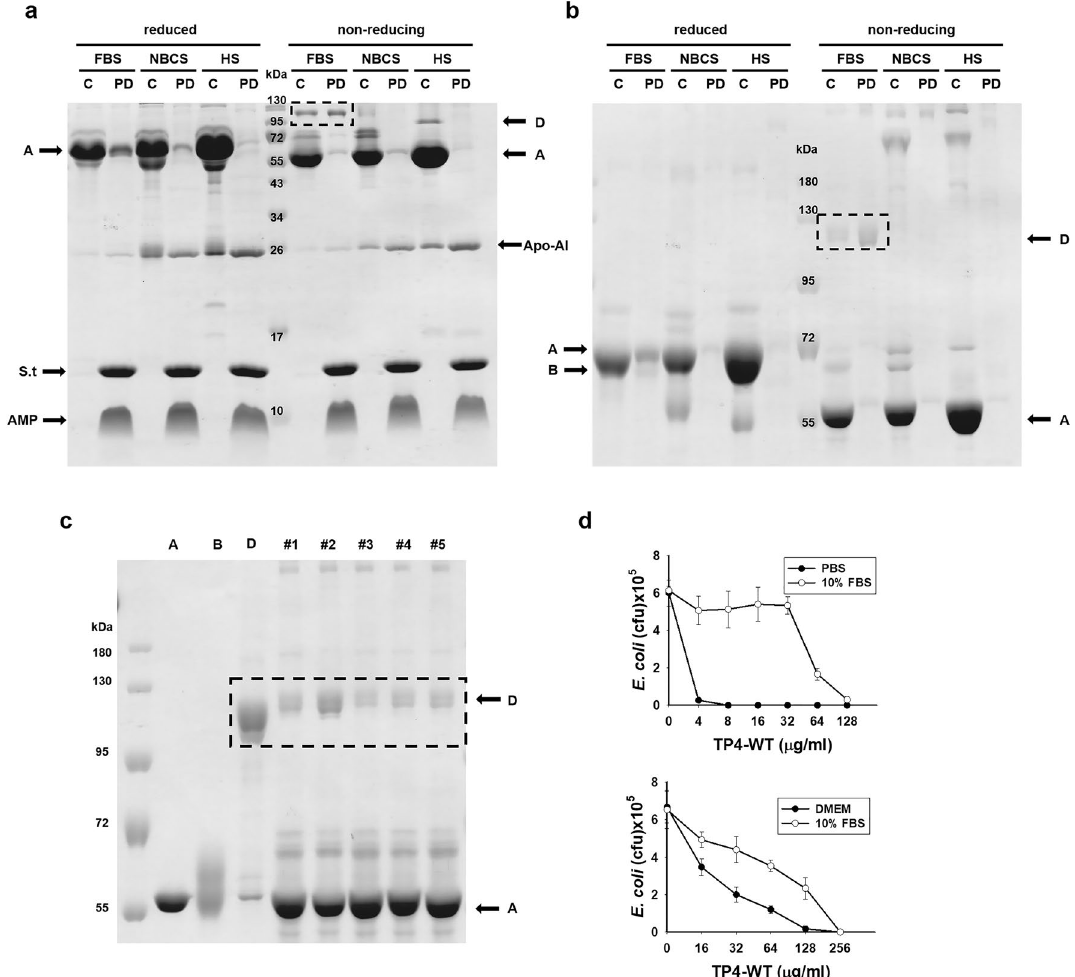
Figure 8. Analyses of albumin and α1–antitrypsin complex in the sera. ( a , b ) 0.25 μl of fetal bovine serum (FBS), newborn calf serum (NBCS) and human serum (HS) were pulled down by biotinylated TP4-A12I,A15I immobilized on Streptavidin-conjugated gel and subjected to 15% ( a ) and 8% ( b ) reduced (2.5% β-ME) and non-reducing SDS-PAGE analyses. C, control serum without pulling down; PD, pulling down ( c ) Analysis of the protein A and D contents of various FBS. 0.25 μl of crude FBS was analyzed by 8% non-reducing SDS- PAGE. # 1 to # 5 were obtained from Gibco, Co. with the lot numbers 1233075 and 1,887,129, CORNIING with the lot number 35010170, Biological Industries with the lot numbers 1823627 and 1,650,071, respectively. ( d ) Susceptibility of TP4 to serum inhibition in PBS and cell culture medium with the developmental stage of bovine, batches of serum sources (Fig. 8). Therefore, the amount of albumin/ α1-antitrypsin complex is very important because bovine serum is a major supplement of culture media which is used for the assay and production of biomolecules. In addition to the protein D (albumin/α1-antitrypsin complex), the culture medium (DMEM) which contains salts and divalent cations is also inhibitory to the anti- microbial activity of TP4 (Fig. 8). To prevent the inhibitory effects of serum component on the antimicrobial activity of AMP, the protein D in the FBS may be depleted by the AMP-immobilized beads before adding to the culture media, DMEM or RPMI. The band shift of TP4-A12I,A15I on native PAGE occurred with bovine protein D, but not with protein A (Fig. 3a). Interestingly, the binding between protein D and TP4-A12I,A15I was blocked if the protein D-con- taining mixture was pre-incubated with ibuprofen, but not with warfarin or phenytoin, before binding to TP4- A12I,A15I (Fig. 7b). It is known that warfarin and ibuprofen bind to human albumin at the binding site I and II, respectively 10 . Furthermore, the conformation changes of albumin could be monitored by the blue shift of fluorescence emission spectrum exerted by tryptophan residues. The movement of tryptophan residues, W131 and W214 located in sites I and II of BSA, induced by drug treatment could be detected by the assay 13,18 . For example, the anionic surfactant sarkosyl drove the blue shifts in both proteins A and D (Fig. 7a). The TP4- A12I,A15I and ibuprofen drove blue shift only in bovine protein D, but not protein A, whereas phenytoin did not exert blue shift in both proteins. These results suggest that the TP4-A12I,A15I and ibuprofen share the same binding site probably at the binding site II of albumin in protein D.